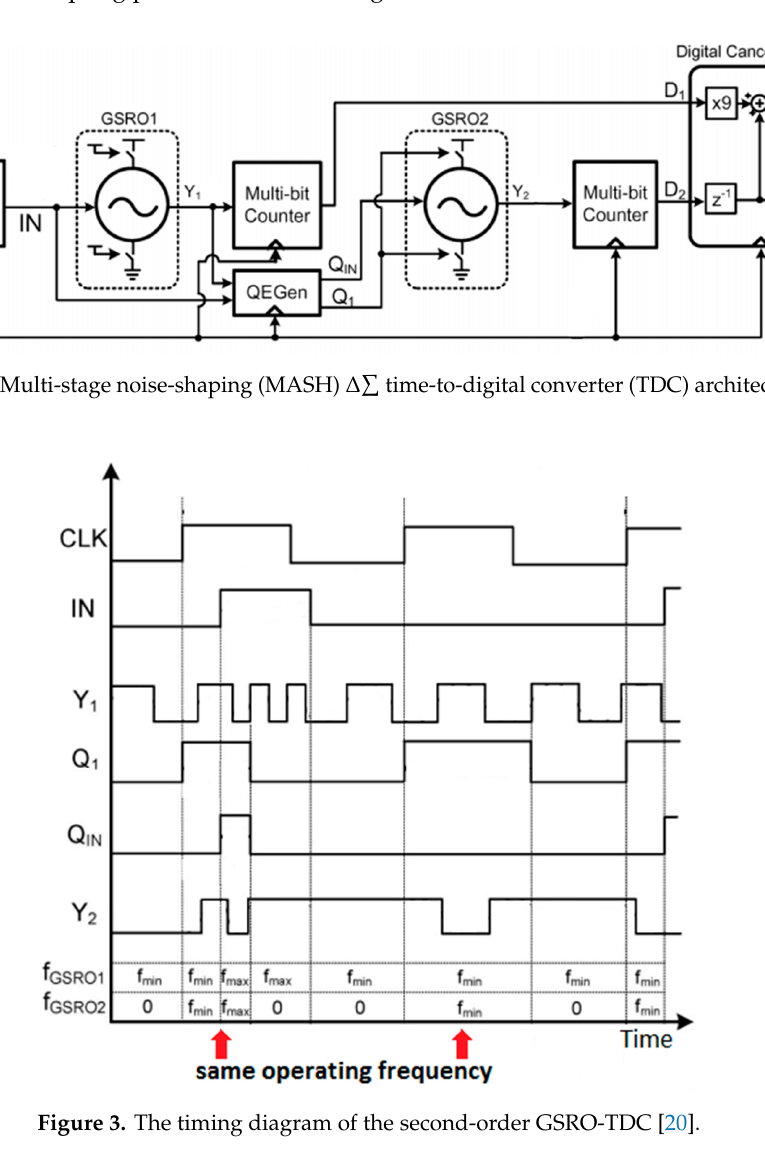
Figure 3. The timing diagram of the second-order GSRO-TDC [20].